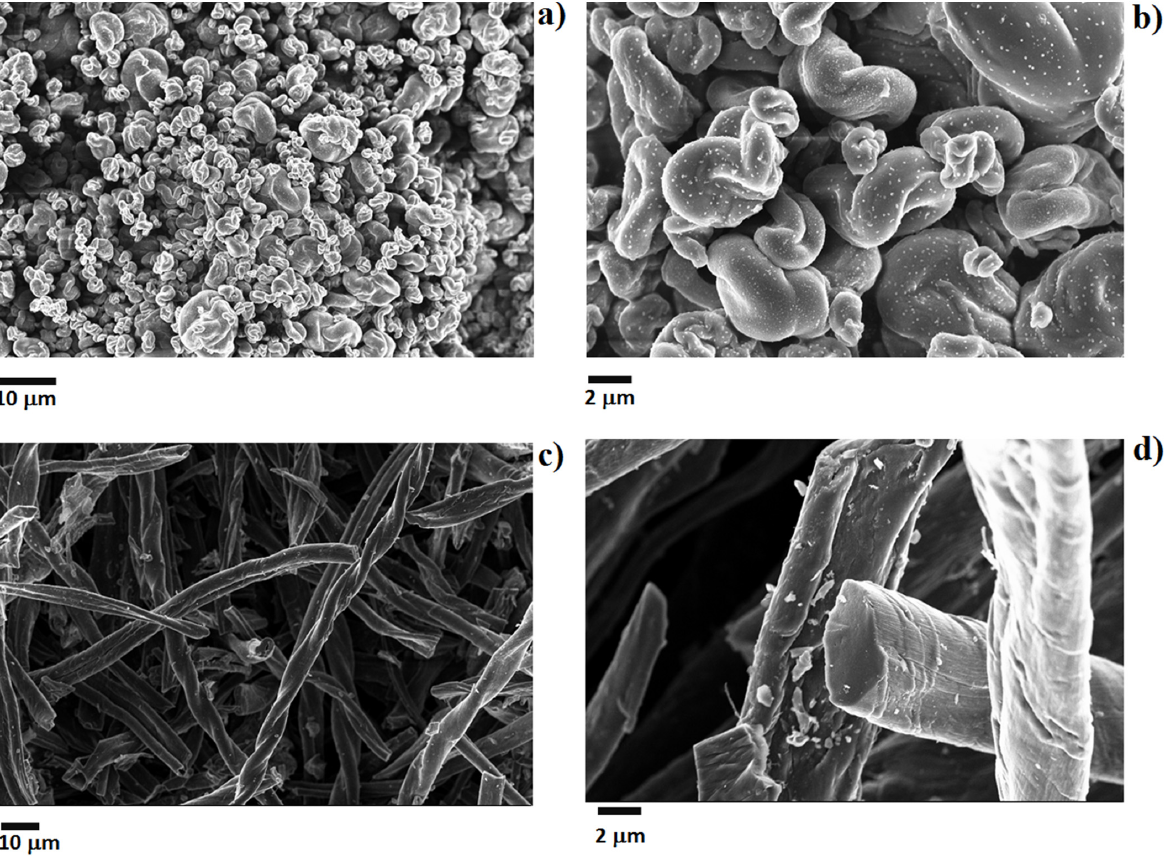
Figure 11. Field emission scanning microscope captures of BC particles produced by pyrolysis at 400 °C of ( a , b ) waste cotton fibers and ( c , d ) cellulose nanocrystals [121]. Reprinted with permission from Wiley Periodicals, LLC.